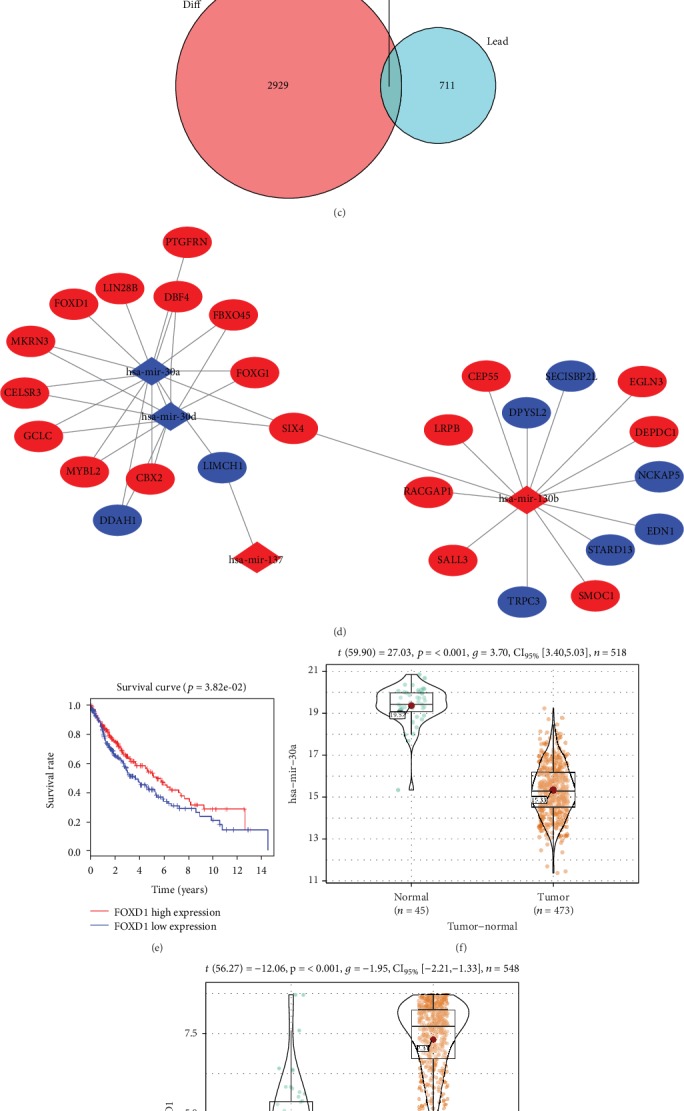
Expression of miR-30a-5p and FOXD1 in LSCC. Volcano plot of DEmiRNAs (a) and DEmRNAs (b) in TCGA-LUSC; (c) Venn diagram of DEmRNAs and predicted target genes; (d) miRNA-mRNA regulatory network; (e) survival curves of FOXD1 gene. The abscissa indicates the time (years), the ordinate indicates survival rate, the red curve indicates high expression, the blue curve indicates low expression, and each vertical node indicates death of a follow-up individual; relative expression level of miR-30a-5p (f) and FOXD1 (g) in the normal group and the tumor group in TCGA-LUSC; The expressions of miR-30a-5p (h) and FOXD1 mRNA (i) in human normal lung epithelial cell line and human LSCC cell lines were detected by qRT-PCR; (j) The protein expressions of FOXD1 in human normal lung epithelial cell line and human LSCC cell lines were detected by WB. ∗P < 0.05.